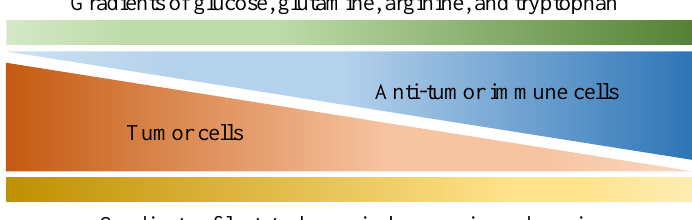
Figure 1. Various gradients within the tumor microenvironment that are differentially associated with anti-tumor activity and tumor growth. Tumor cells are known for their aberrant metabolic activity that leads to local depletion of a variety of nutrients, including glucose, glutamine, arginine and tryptophan, which effectively hinder anti-tumor activities provided by immune cells that also depend on these nutrients. In addition, metabolites such as lactate, kynurenine and adenosine are released by tumor cells, dampening anti-tumor immunity along with hypoxia.